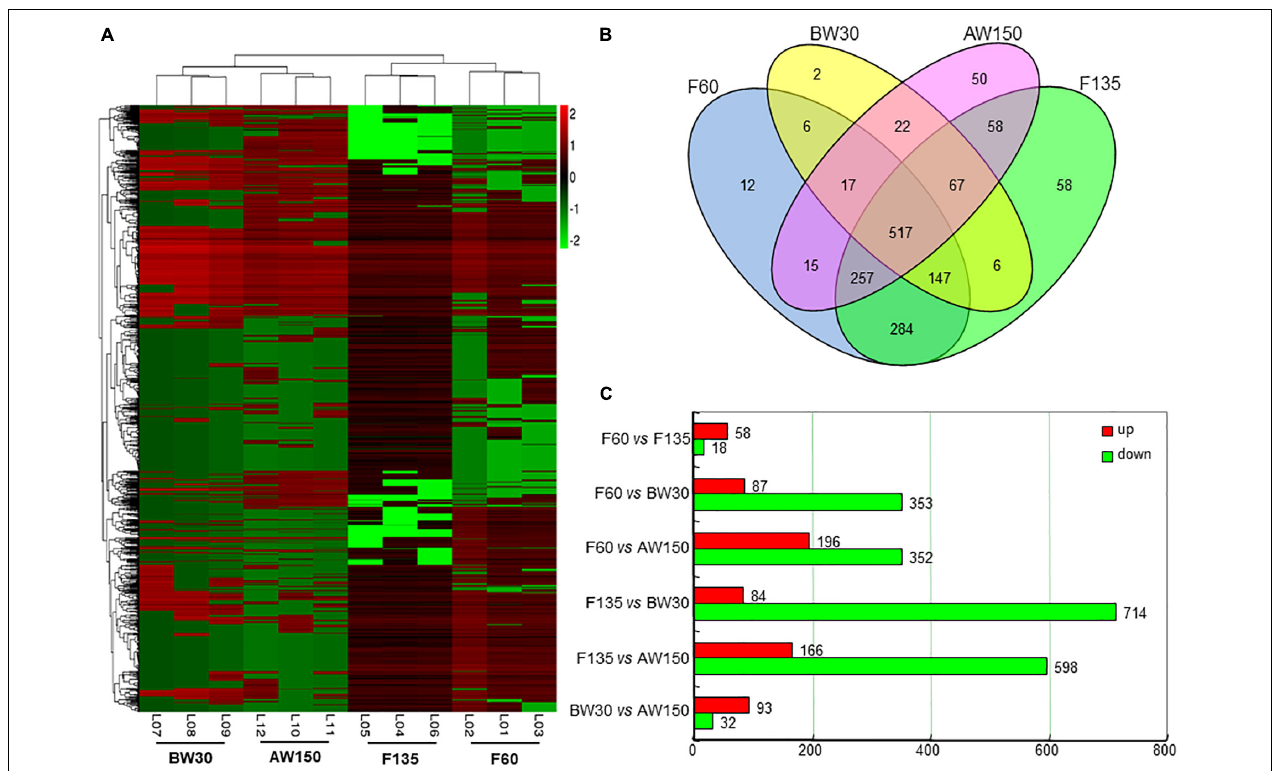
FIGURE 3 | (A) Hierarchical cluster analysis (heat map) represents all differentially expressed circRNAs (DECs) between F60 vs. F135, BW30 vs. AW150 groups. Red and green denoted high and low expressions, respectively. (B) Venn diagram showing the DECs at the four developmental stages. (C) Numbers of up-regulated or down-regulated circRNAs in goat rumens during fetal and prepubertal